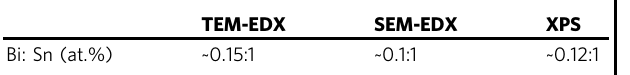
Table 1 The molar concentration of Bi and Sn in the Bi 0.1